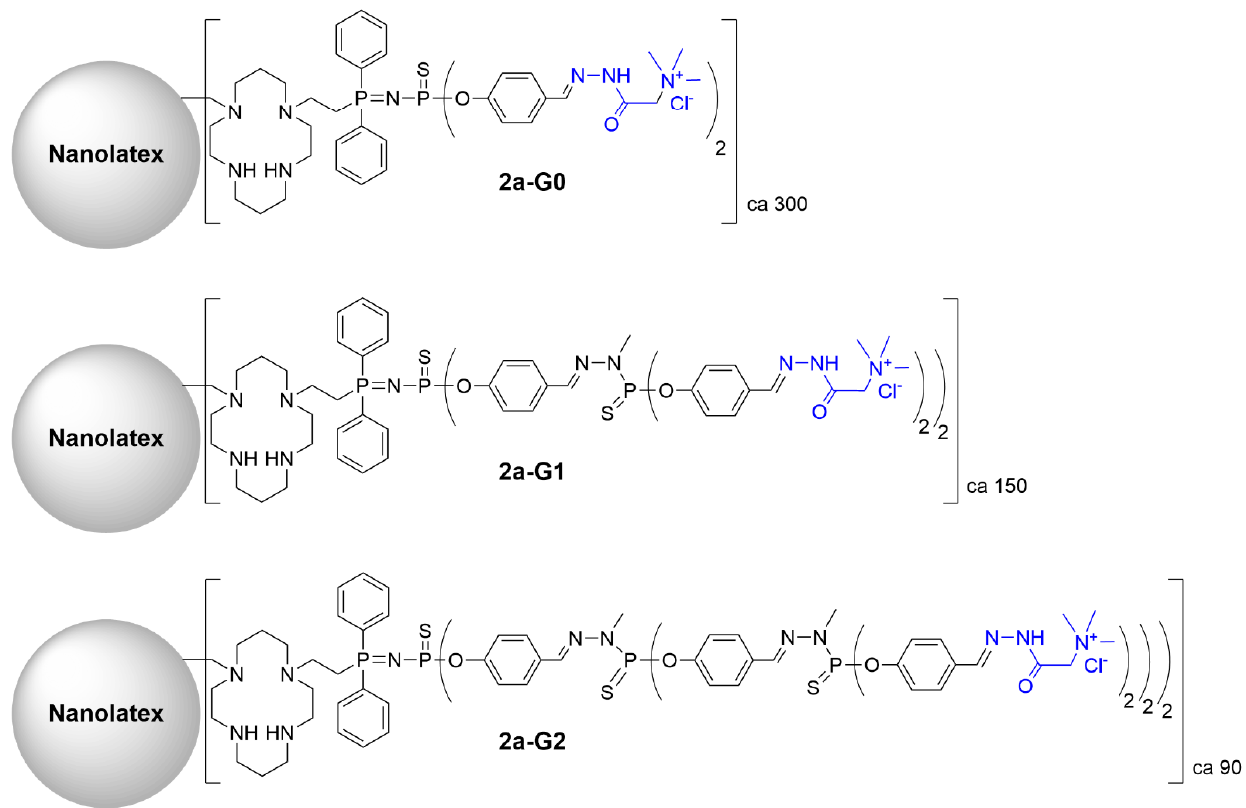
Figure 5. Nanolatex functionalized with phosphorus dendrons (generations 0 to 2) bearing the Girard T reagent as terminal functions. Cyclam moieties were suitable for the complexation of Cu 2+ ions.